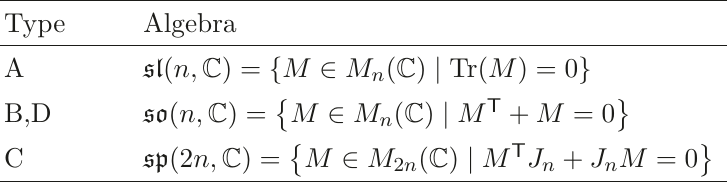
(cid:9) Table 1 . Defining representations of classical Lie